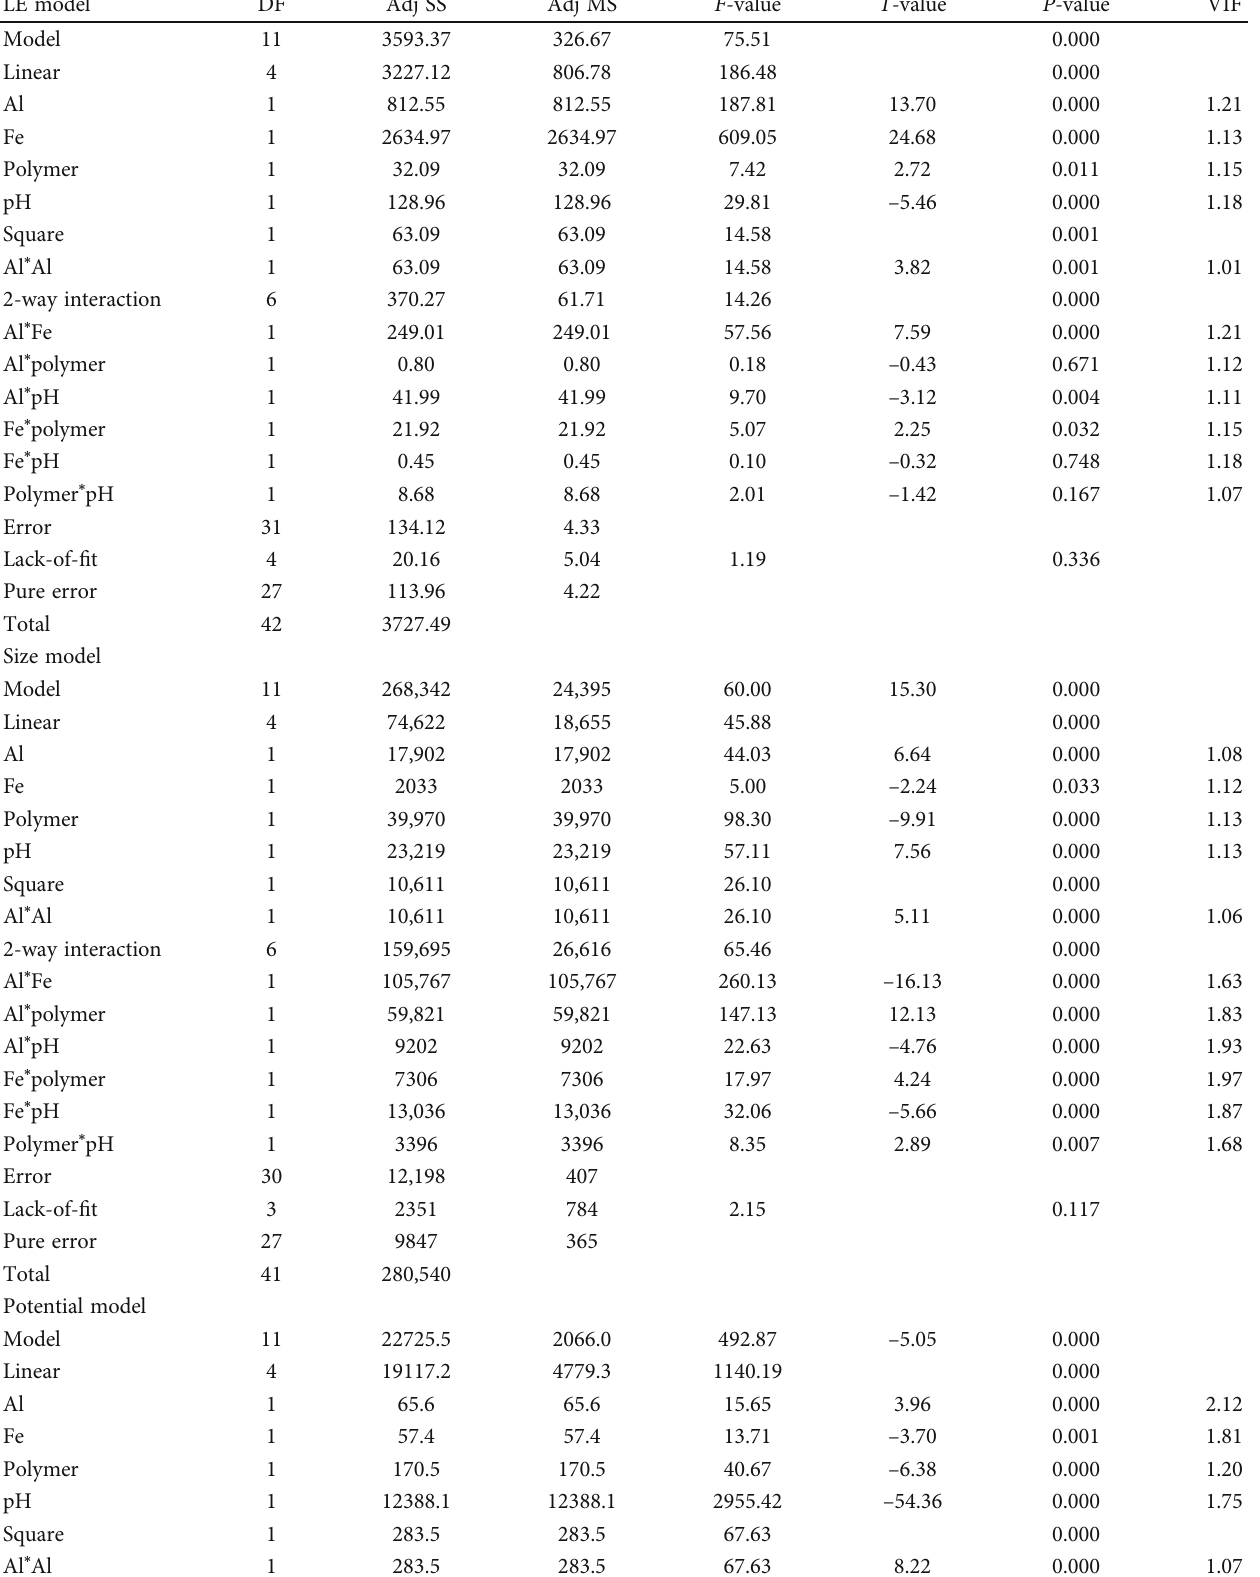
Table 2: ANOVA table for % LE, particle size, and zeta